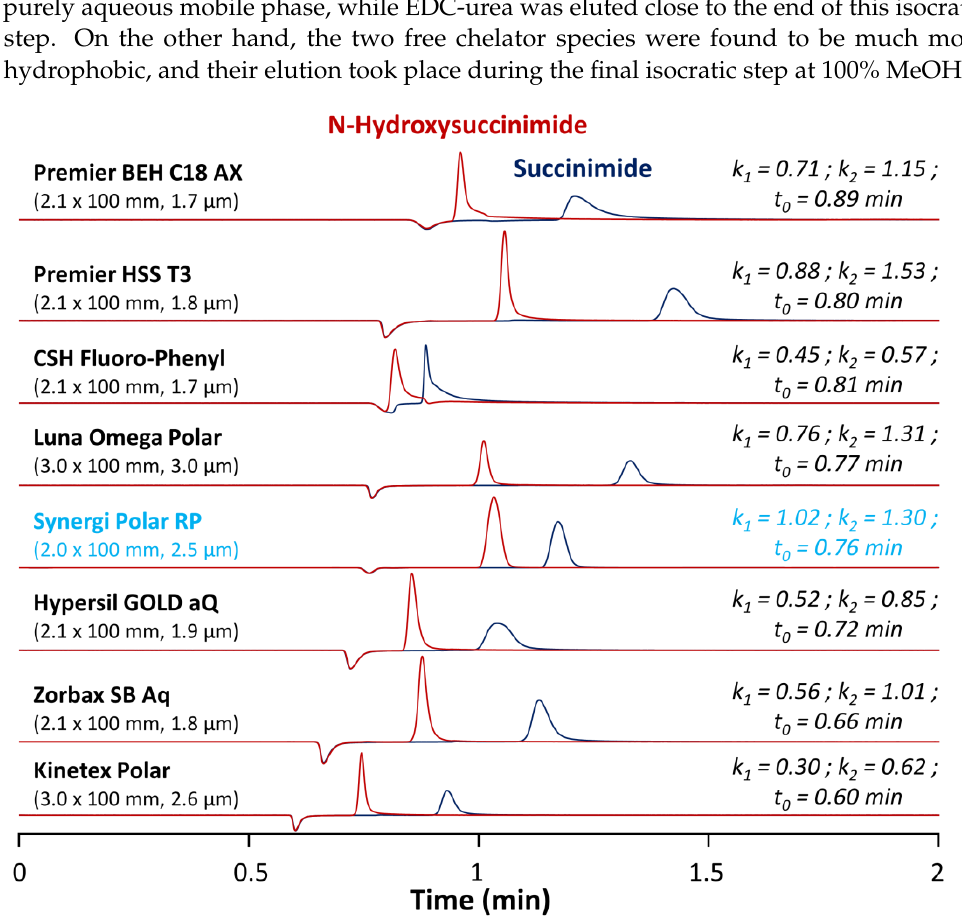
Figure 2. Chromatograms illustrating the screening results for separation of N -hydroxysuccinimide and succinimide obtained on eight different columns in isocratic mode with 0.1% TFA in water at 40 °C.